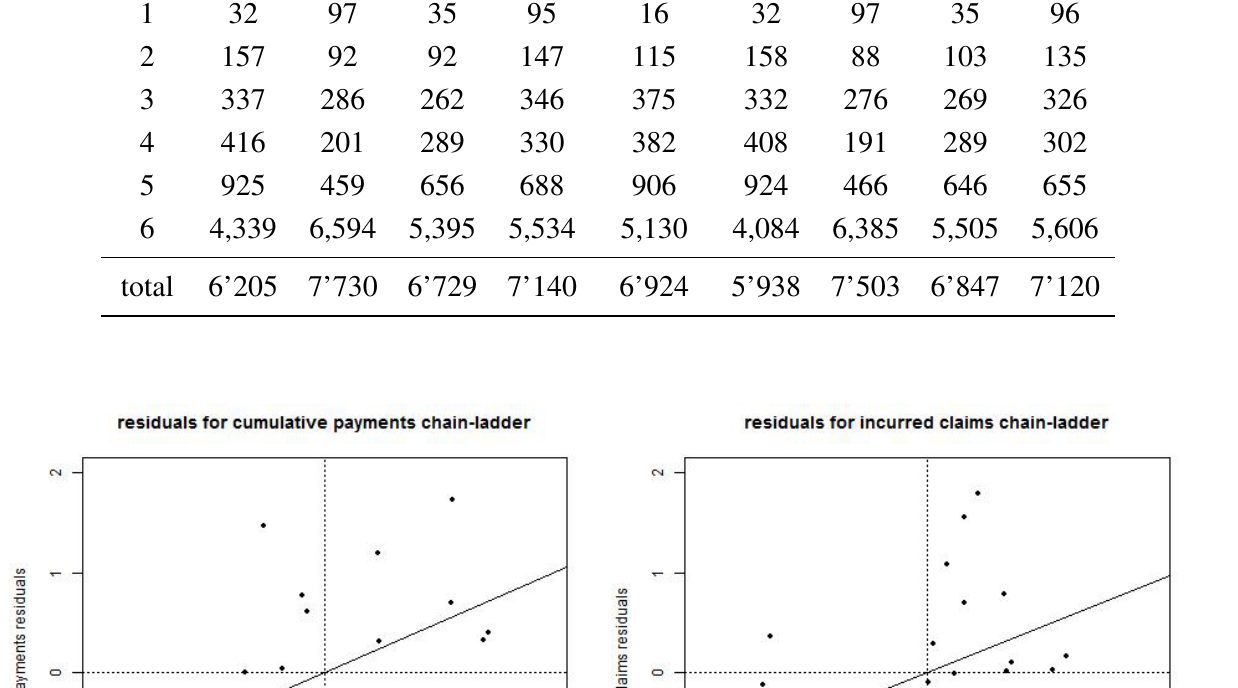
Table 2. Resulting reserves from the Hertig’s chain-ladder (HCL) method based on paid and incurred; from the log-normal Munich chain-ladder (LN–MCL) method based on paid and incurred; from the modified Munich chain-ladder (mMCL) paid method; the classical chain-ladder (CL) method based on paid and incurred (inc.); and the Quarg and Mack Munich chain-ladder (QM–MCL) method paid and incurred. HCL LN-MCL mMCL CL QM-MCL a.y. i paid inc. paid inc. paid paid inc. paid inc.